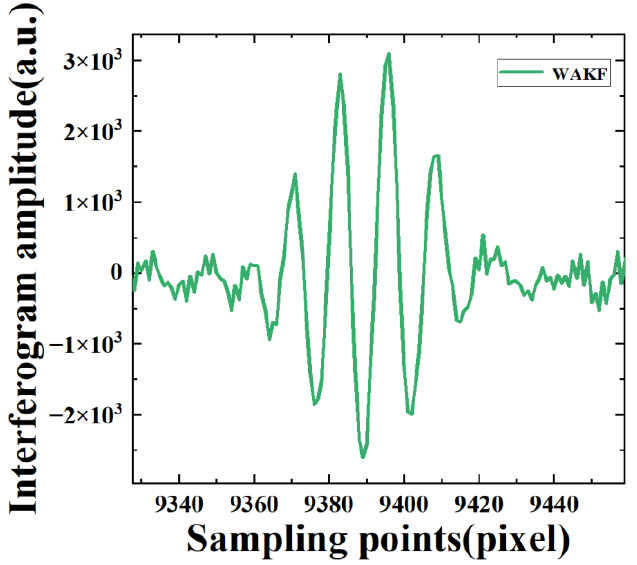
Figure 5. The amplitudes of the step interferogram as a function of sampling points are denoised with WAKF for the 747th pixel at a sampling frequency of 80 MHz.